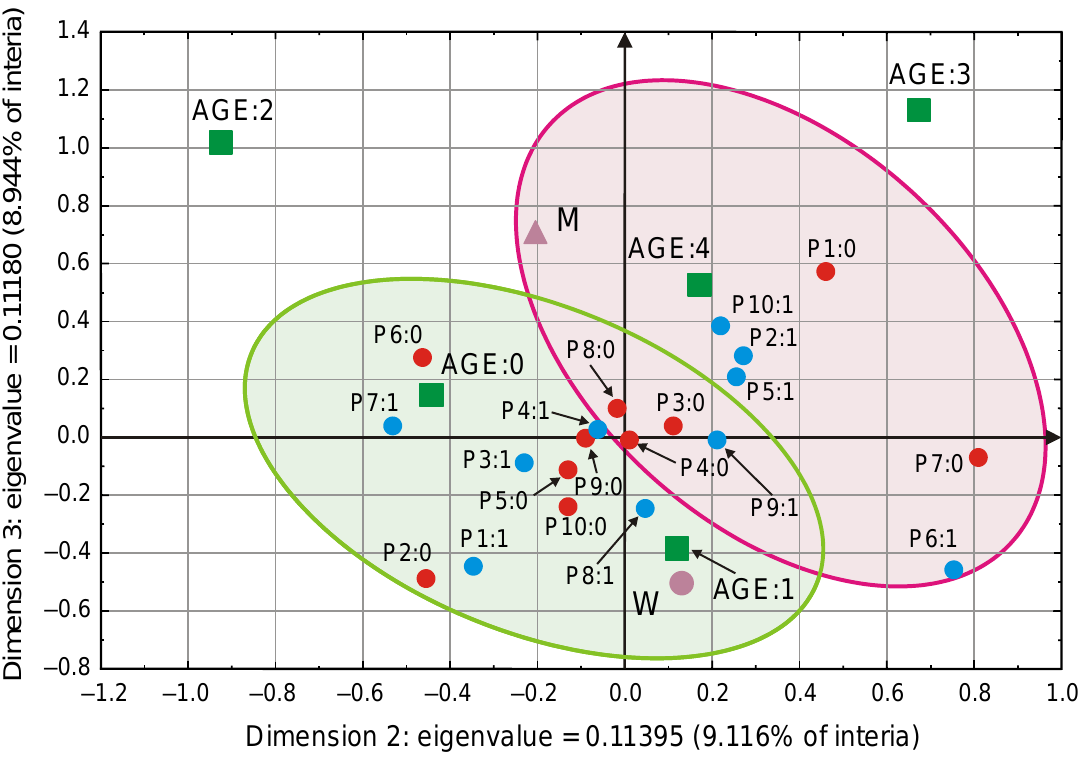
Figure 7. Two-dimensional plot of column coordinates—dimension 2 × 3. Input table (rows × columns): 27 × 27 Burt